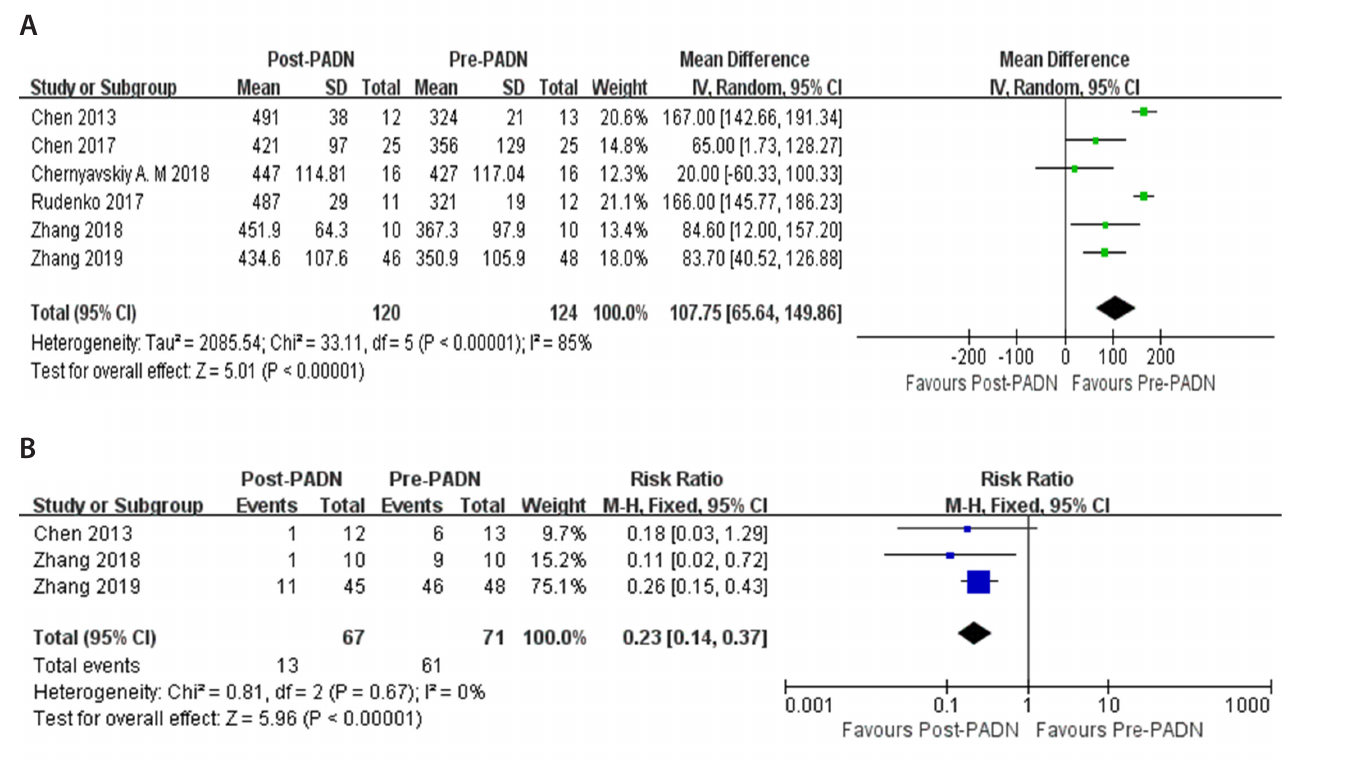
Fig. 5 - Forest plot for comparison of quality of life between post pulmonary artery denervation (PADN) period and pre-PADN period: A) 6-minute walk distance (meter); B) New York Heart Association cardiac function grading. CI=confidence interval; SD=standard